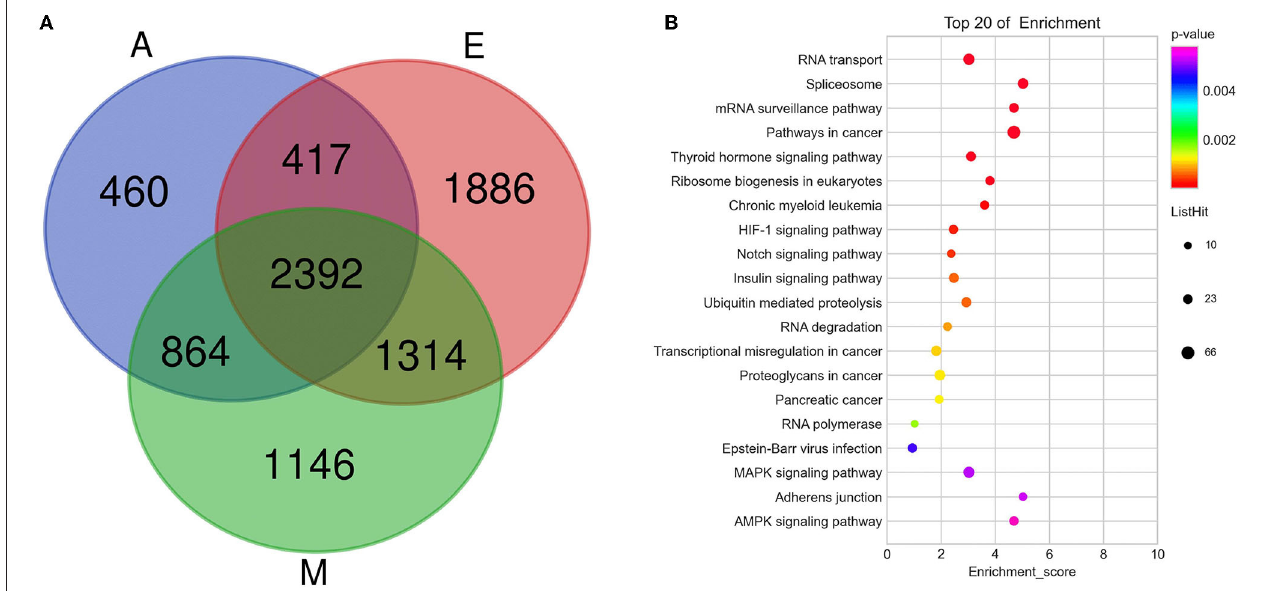
FIGURE 4 | The consistently modified genes in yak LD enrich the analysis. (A) Venn diagram showed the overlap of m6A peaks in the three developmental stages; (B) KEGG enrichment of consistently modified genes in yak LD in the three developmental stages.